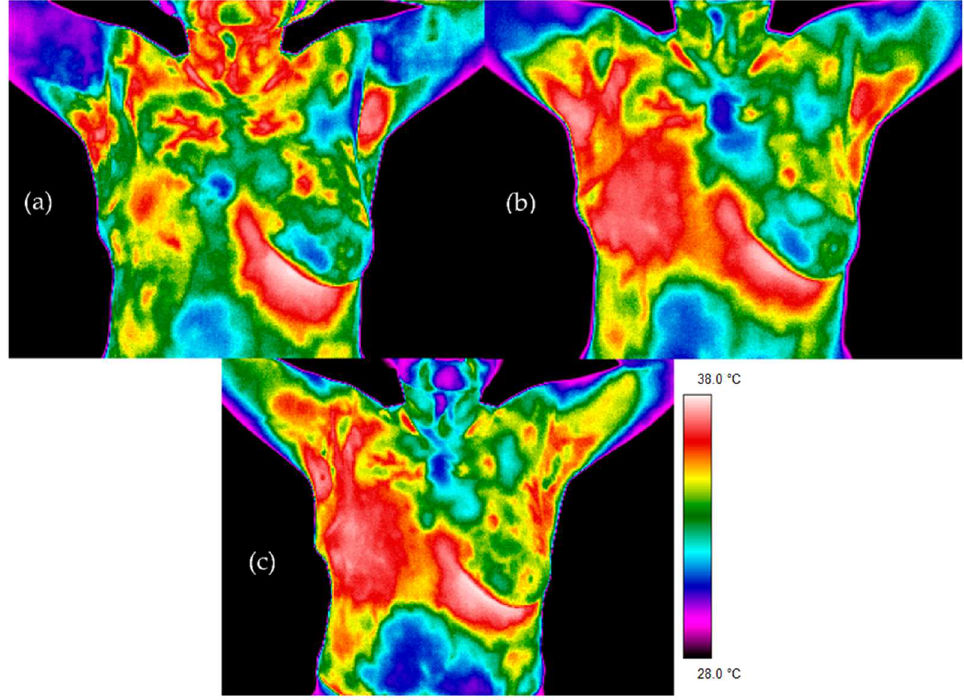
Figure 3. Examples of thermograms for patient 2: ( a ) before radiotherapy, ( b ) 2 months after radiotherapy and ( c ) 6 months after radiotherapy.